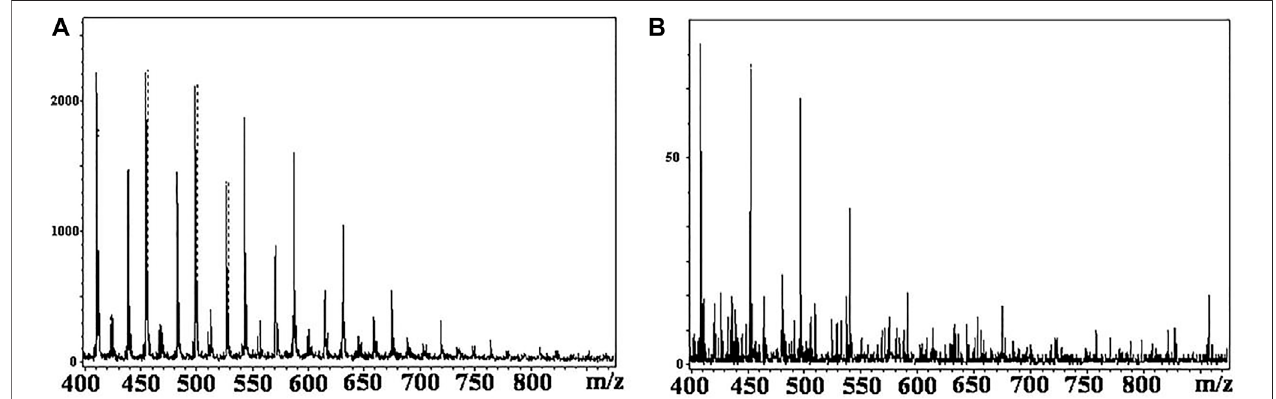
FIGURE1 | MALDI-MSspectrum forthe PEG sample (1 mg/ml) received directly from the monolithic TLC plate without additional matrix compounds. (A) 29% (w/ w) GMA and (B) 14% (w/w) GMA. Figure reprinted with permission from Kucherenko et al. (2018). Copyright (2018) WILEY-VCH Verlag GmbH & Co. KGaA.